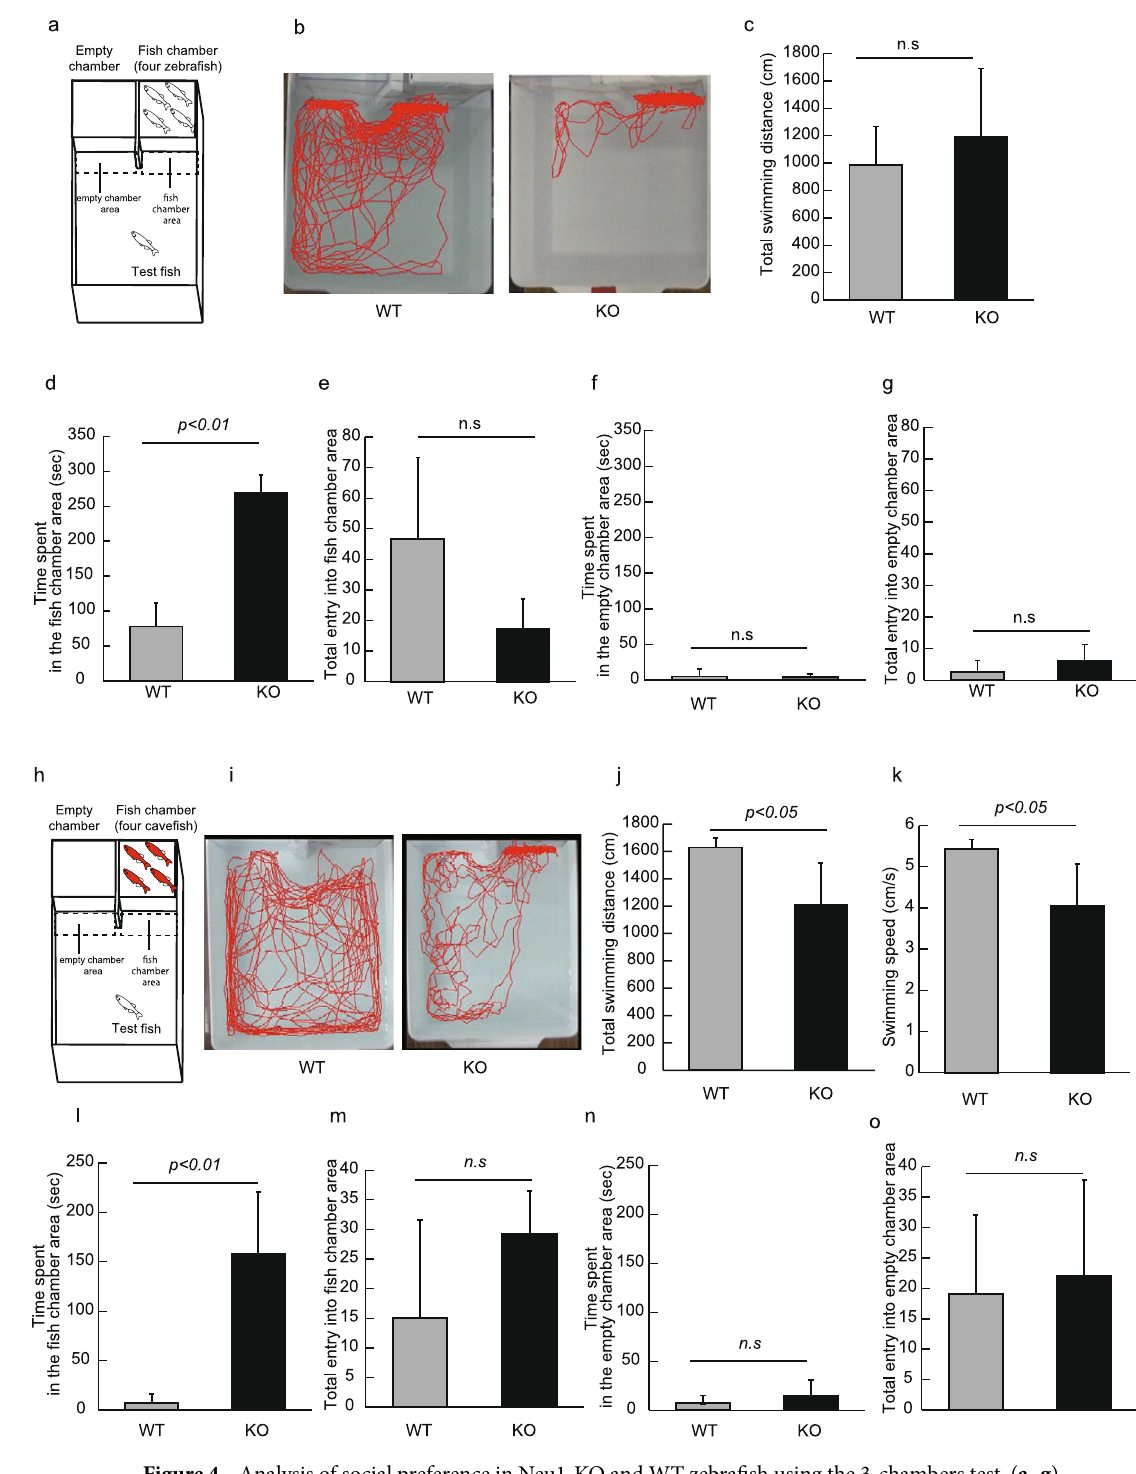
Figure 4. Analysis of social preference in Neu1-KO and WT zebrafish using the 3-chambers test. ( a – g ) Analysis of the 3-chambers test with 4 unfamiliar zebrafish in Neu1-KO and WT zebrafish. ( a ) Apparatus of the 3-chambers test using 4 zebrafish. ( b ) Tracking of WT and Neu1-KO zebrafish. ( c ) Total swimming distance. ( d ) Time spent in the fish chamber area. ( e ) Total entry into the fish chamber area. ( f ) Time spent in the empty chamber area. ( g ) Total entry into the empty chamber area. n = 8 for each group. ( h – o ) Analysis of the 3-chambers test with 4 cavefish in Neu1-KO and WT zebrafish. ( h ) Apparatus of the 3-chambers test with 4 cavefish. ( i ) Tracking of WT and Neu1-KO zebrafish. ( j ) Total swimming distance. ( k ) Swimming speed. ( l ) Time spent in the fish chamber area. ( m ) Total entry into fish chamber area. ( n ) Time spent in the empty chamber area. ( o ) Total entry into empty chamber area. n = 10 for each group. Results are shown as means ± standard deviation. All values were compared using Mann–Whitney U test. n.s., not